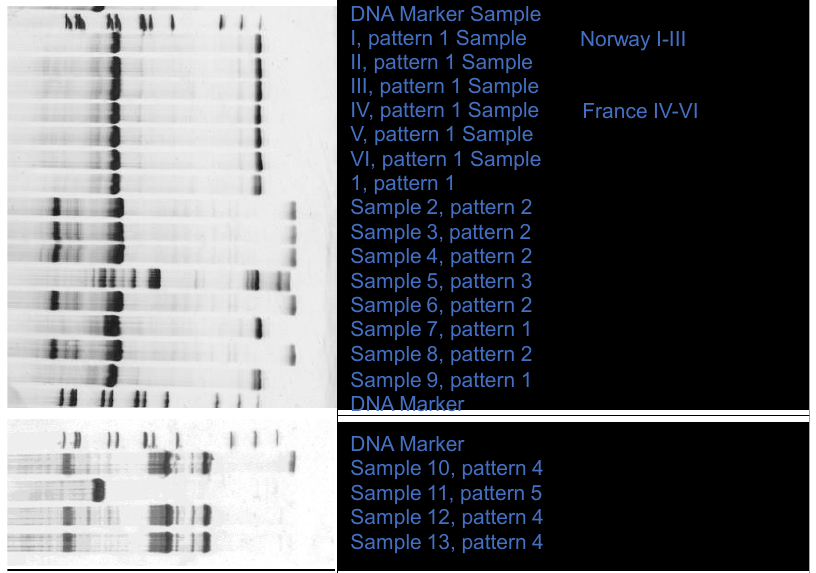
Figure 1. Fresh and frozen scallop samples: RFLP analysis of the ITS amplicons, digested by Alu I. Clean Gel 15%, silver staining. Samples I-VI: fresh king scallops ( Pecten maximus ), samples 1–13: frozen scallop meat products identified as king scallops ( P. maximus/ P. jacobaeus ) (1, 7, 9), Atlantic sea scallops ( Placopecten magellanicus ) (2, 3, 4, 6, 8, 10, 12, 13) and Japanese scallop ( Mizuhopecten yessoensis ) (5), used Marker was 100 bp DNA ladder (Roth,